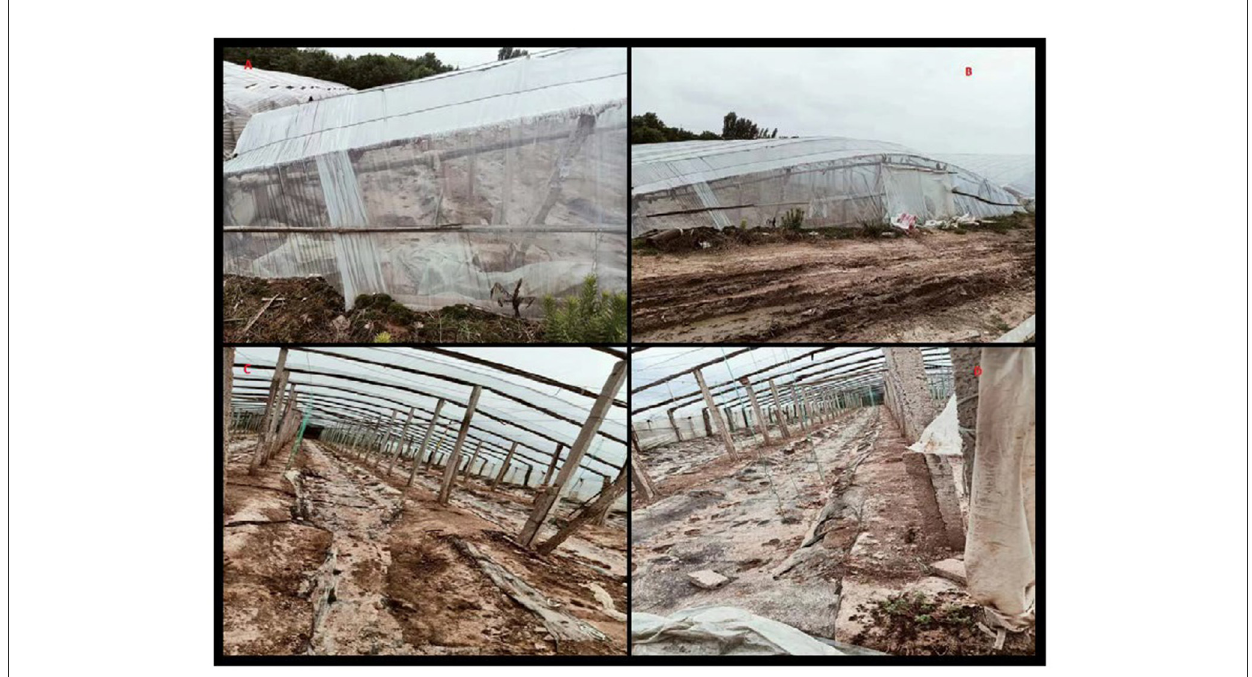
FIGURE2 Photo of greenhouse where the patient was working at that time. Picture of (A, B) are external photos of greenhouse, picture (C, D) are internal photos of